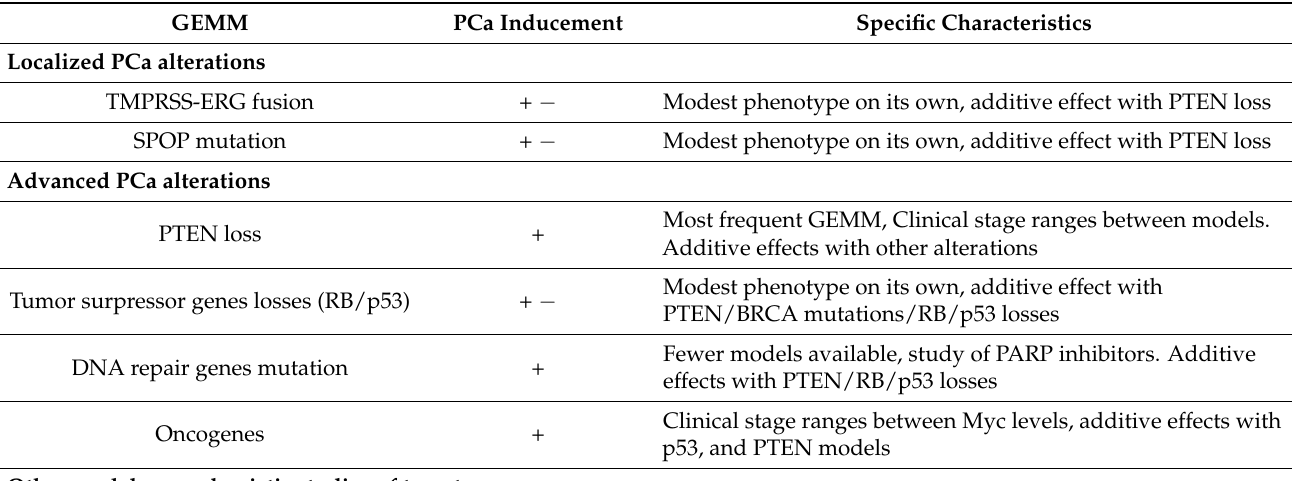
Table 2. Overview of possible targetable pathways for genetically engineered mouse models (GEMM) of prostate cancer (PCa). Adapted from